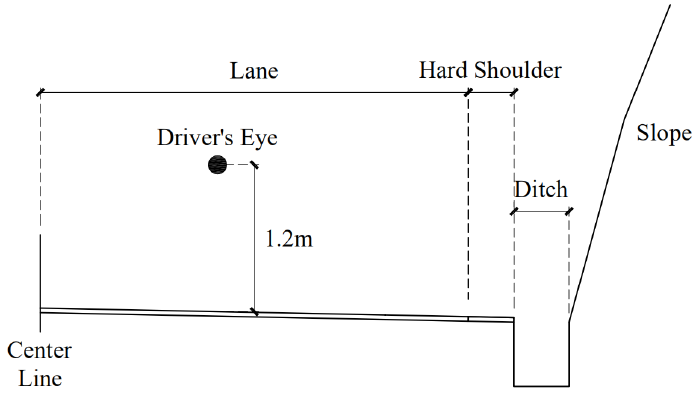
Figure 8. Calculate highway semi-cross section layout. Table 1. The calculation parameters of S.S.D. calculation.